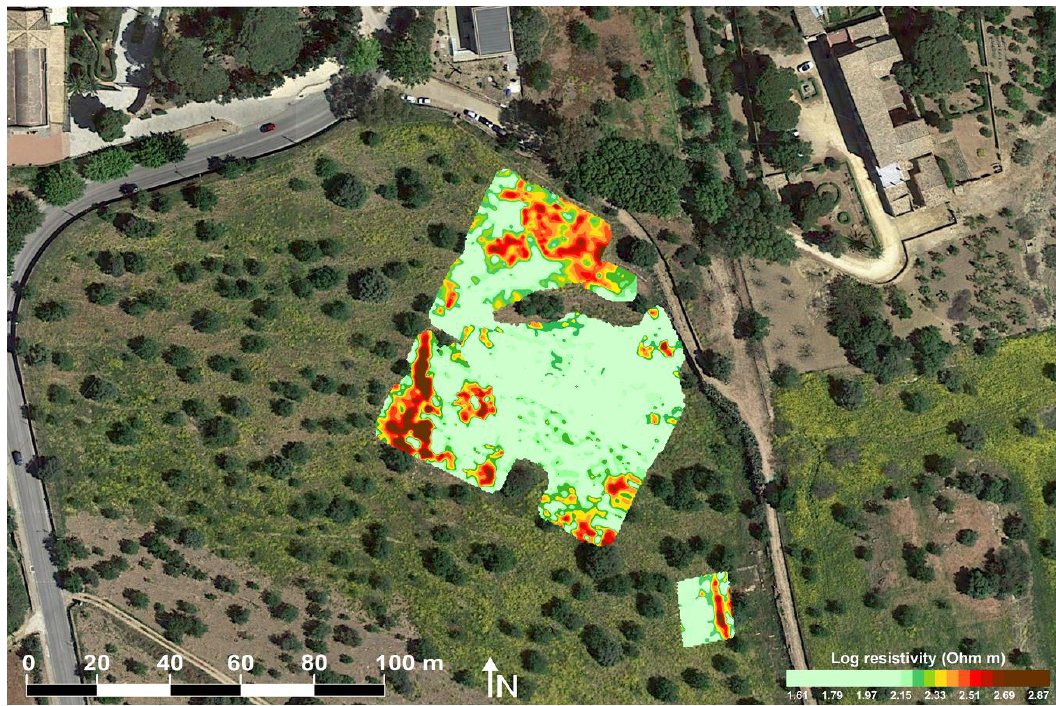
Figure 4. Modelled electrical resistivity map relative to 1 m in depth on a Google Earth TM satellite image (2016): areas 1 and 2 (modified by [16]).